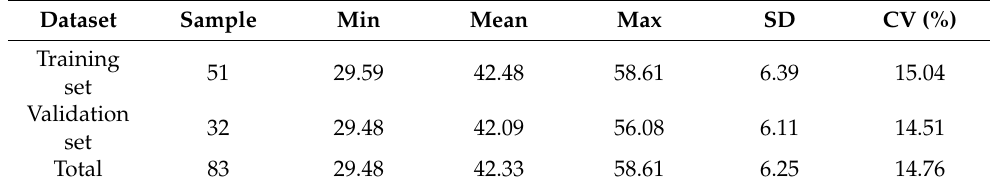
Table 2. Statistical summary of the in situ SPAD values of summer maize using a SPAD-502 Plus device.